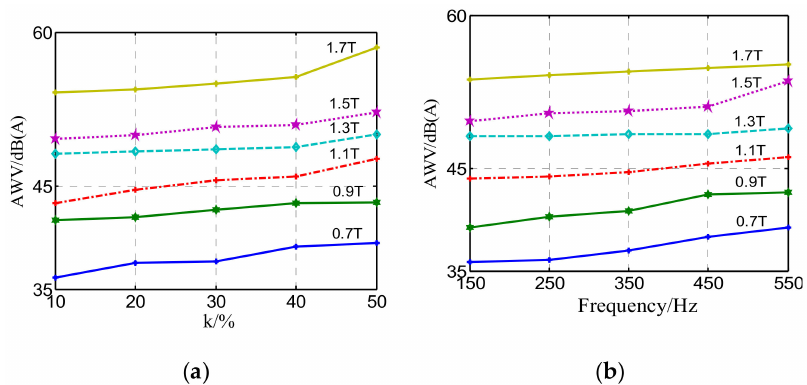
Figure 8. A-weighted noise value under di ff erent harmonic magnetizations: ( a ) E ff ect of varying harmonic content on noise ( n = 5); ( b ) e ff ect of superposed harmonic excitation frequency on noise when k =